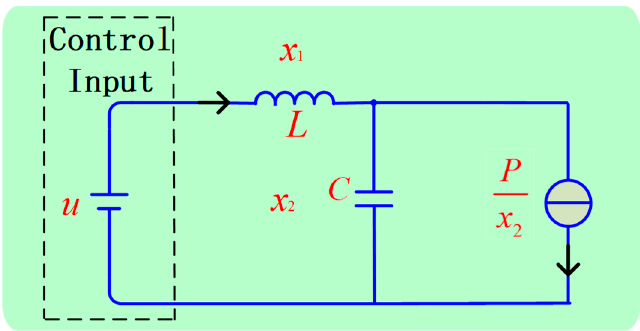
Figure 2. An equivalent average model of the DC microgrid.